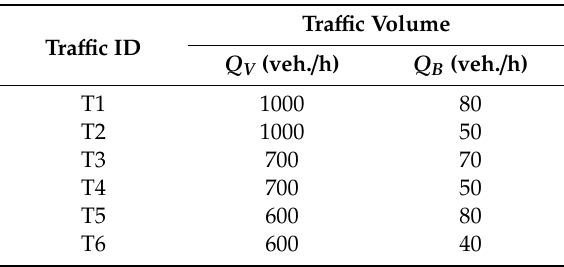
Table 5. Tra ffi c volume.